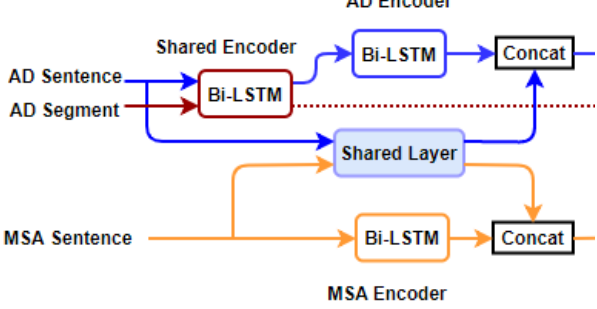
Figure 4. The Layout of shared-private scheme.